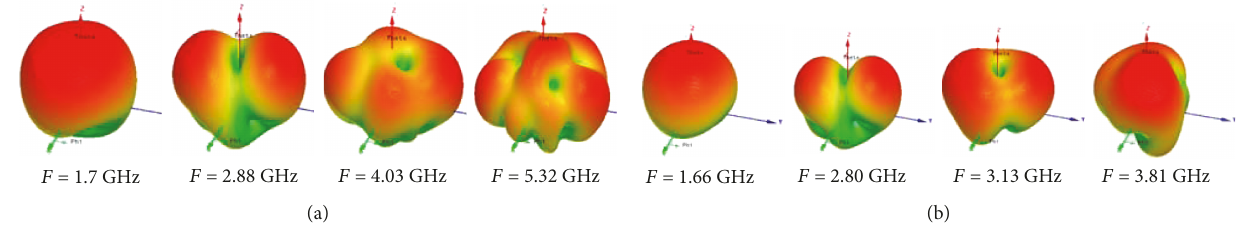
Figure 5: Simulated 3D-radiation patterns at resonant frequencies for antennas: (a) A0 and (b)